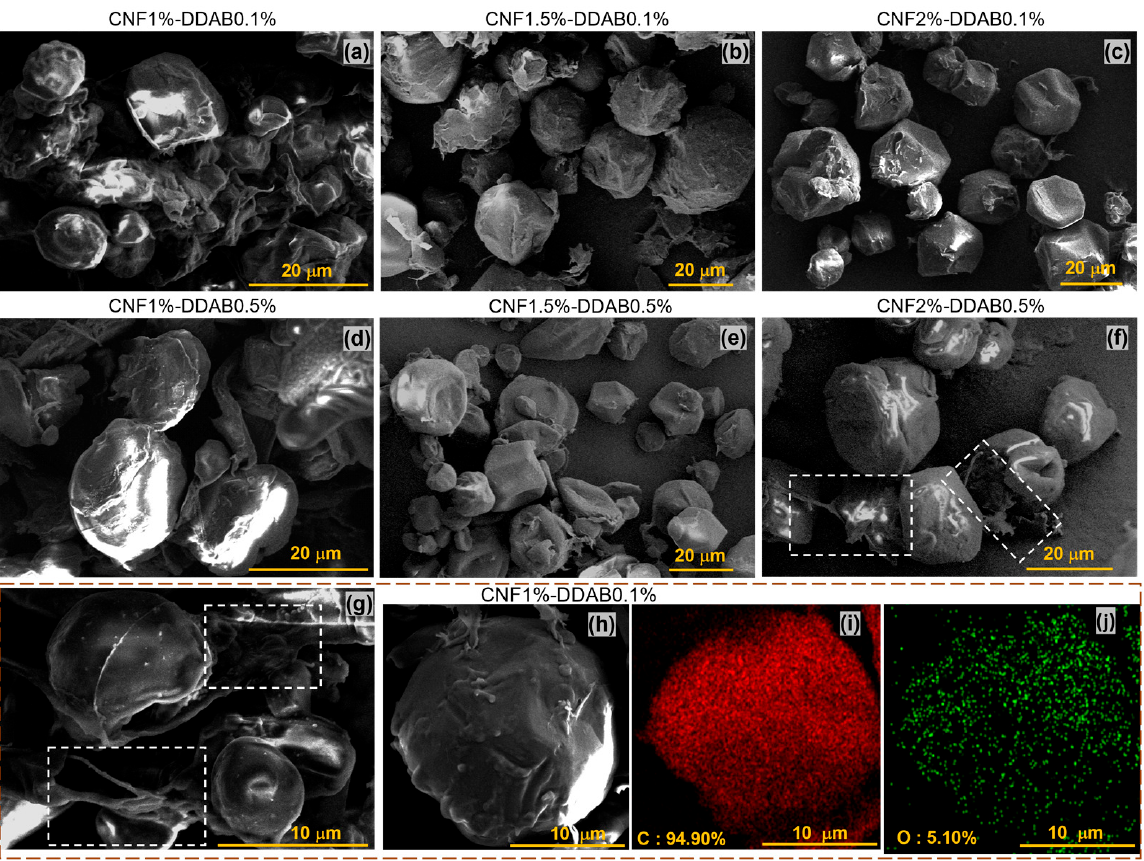
Figure 4. SEM images of CNF emulsion droplets for CNF contents in ( a ) 1%, ( b ) 1.5%, and ( c ) 2% at 0.1 wt.% DDAB content and in ( d ) 1%, ( e ) 1.5%, and ( f ) 2% at 0.5 wt.% DDAB content. ( g ) Another SEM image of CNF1%-DDAB0.1% shows obviously the aqueous CNF chain as the bridge connect- ing between droplets. Its EDS maps showing the elemental content and distribution of ( i ) carbon and ( j ) oxygen for the individual droplet are shown in ( h ). The white dashed wireframe in ( f ) and ( g ) mark the flexible polymer chains outside the solid droplets.